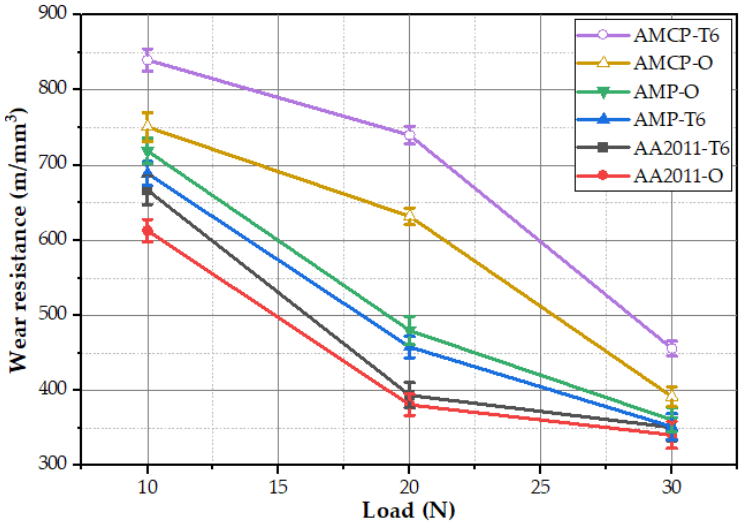
Figure 18. Wear resistance of the initial materials, AMPs, and AMCPs at both temper conditions.